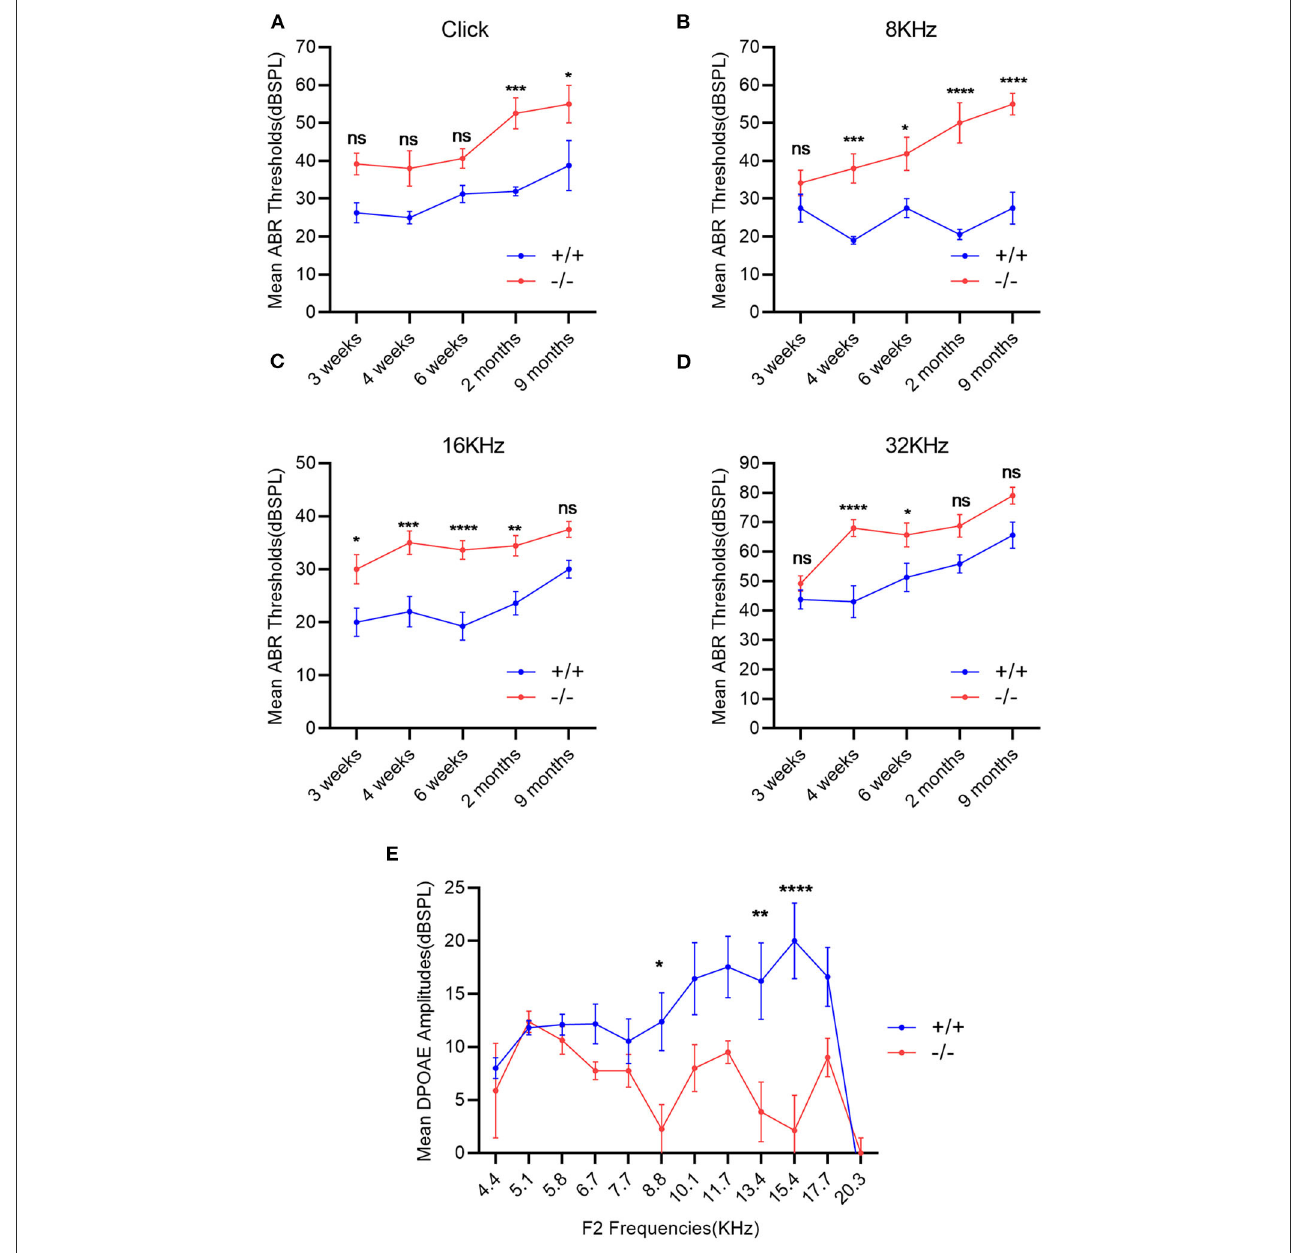
FIGURE3 Evaluation of hearing impairment through auditory brainstem response (ABR) and distortion product otoacoustic emission (DPOAE). (A–D) : Wild-type mice ( + / + , n = 14) and mutant mice (-/-, n = 14) were measured using the ABR thresholds at different stimulus frequencies and different time points. The mutant mice showed significantly higher mean ABR thresholds at each stimulus frequency and at several time points compared with the wild-type mice. (E) DPOAE amplitudes were recorded in wild-type mice ( + / + , n = 9) and mutant mice (-/-, n = 8) at the age of 2 months. The mean DPOAE amplitudes of mutant mice were significantly lower than those of the wild-type mice at 8.8KHz, 13.4 and 15.4KHz. The error bar represents the standard error (SE) of the mean. * P < 0.05, ** P < 0.01, *** P < 0.001, **** P <